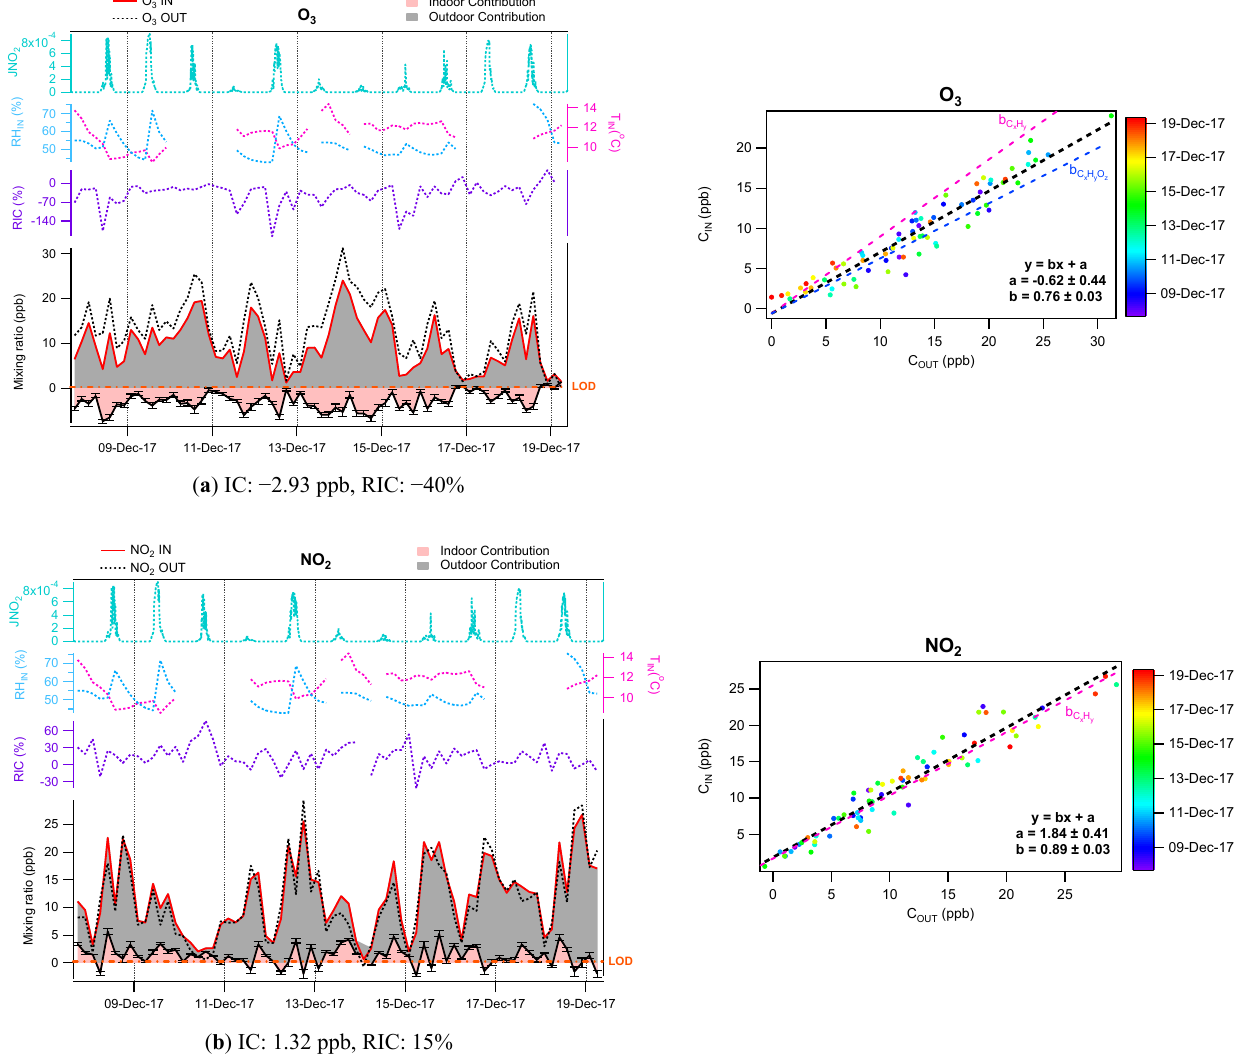
Figure 9. IC-OC contributions ( left ) and scatter plots of indoor-outdoor concentrations ( right ) for ( a ) O 3 and ( b ) NO 2 . Error bars represent 1 σ .